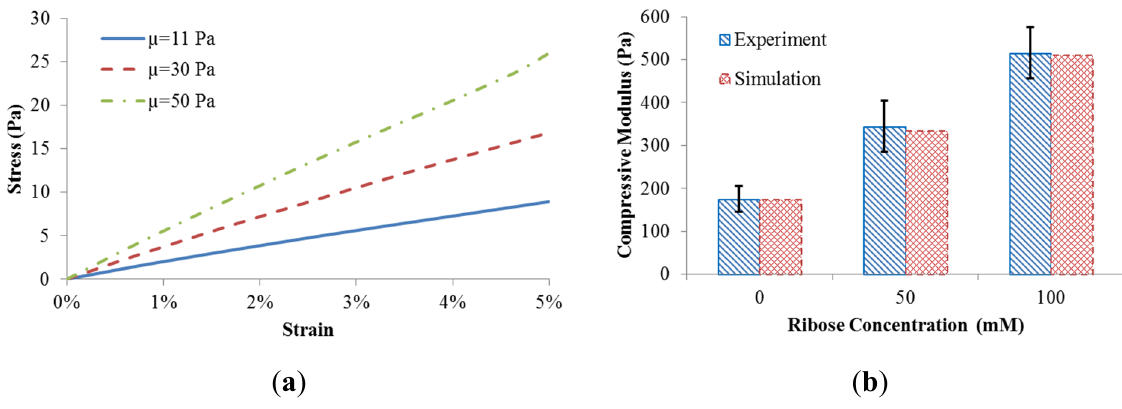
Figure 2. ( a ) Scaffold behavior in response to matrix shear modulus; ( b ) Model validation.